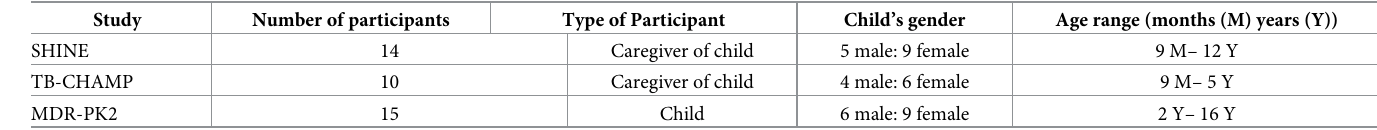
Table 2. Semi-structured interviews with caregivers and children in three qualitative studies of treatment acceptability.